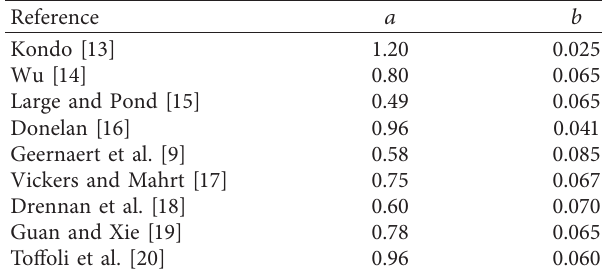
Table 1: Coefficients a and b in (7) from various